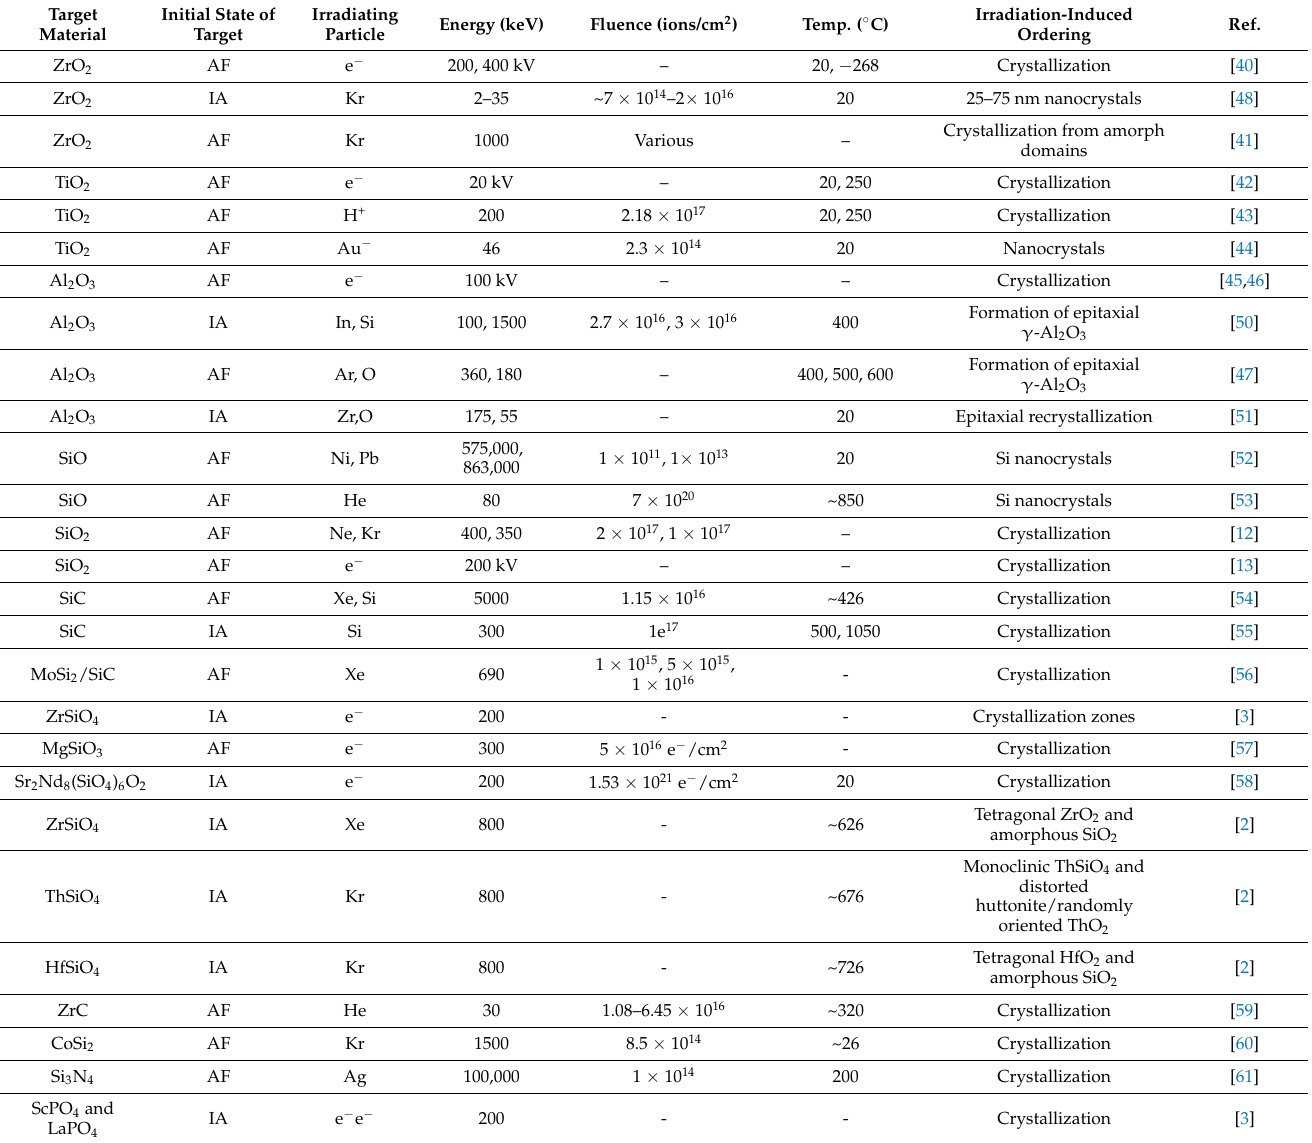
Table 1. Summary of literature reporting irradiation-induced a-to-c transformations in metal oxides; AF = amorphous as fabricated, IA = amorphized by irradiation prior to second